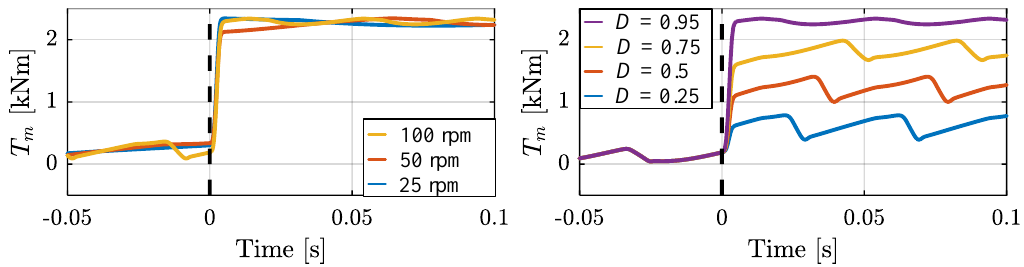
Figure 22. Transient response PSDS Version 2 in the time domain at various speeds ( left plot ) and displacement step up to various displacements ( right plot